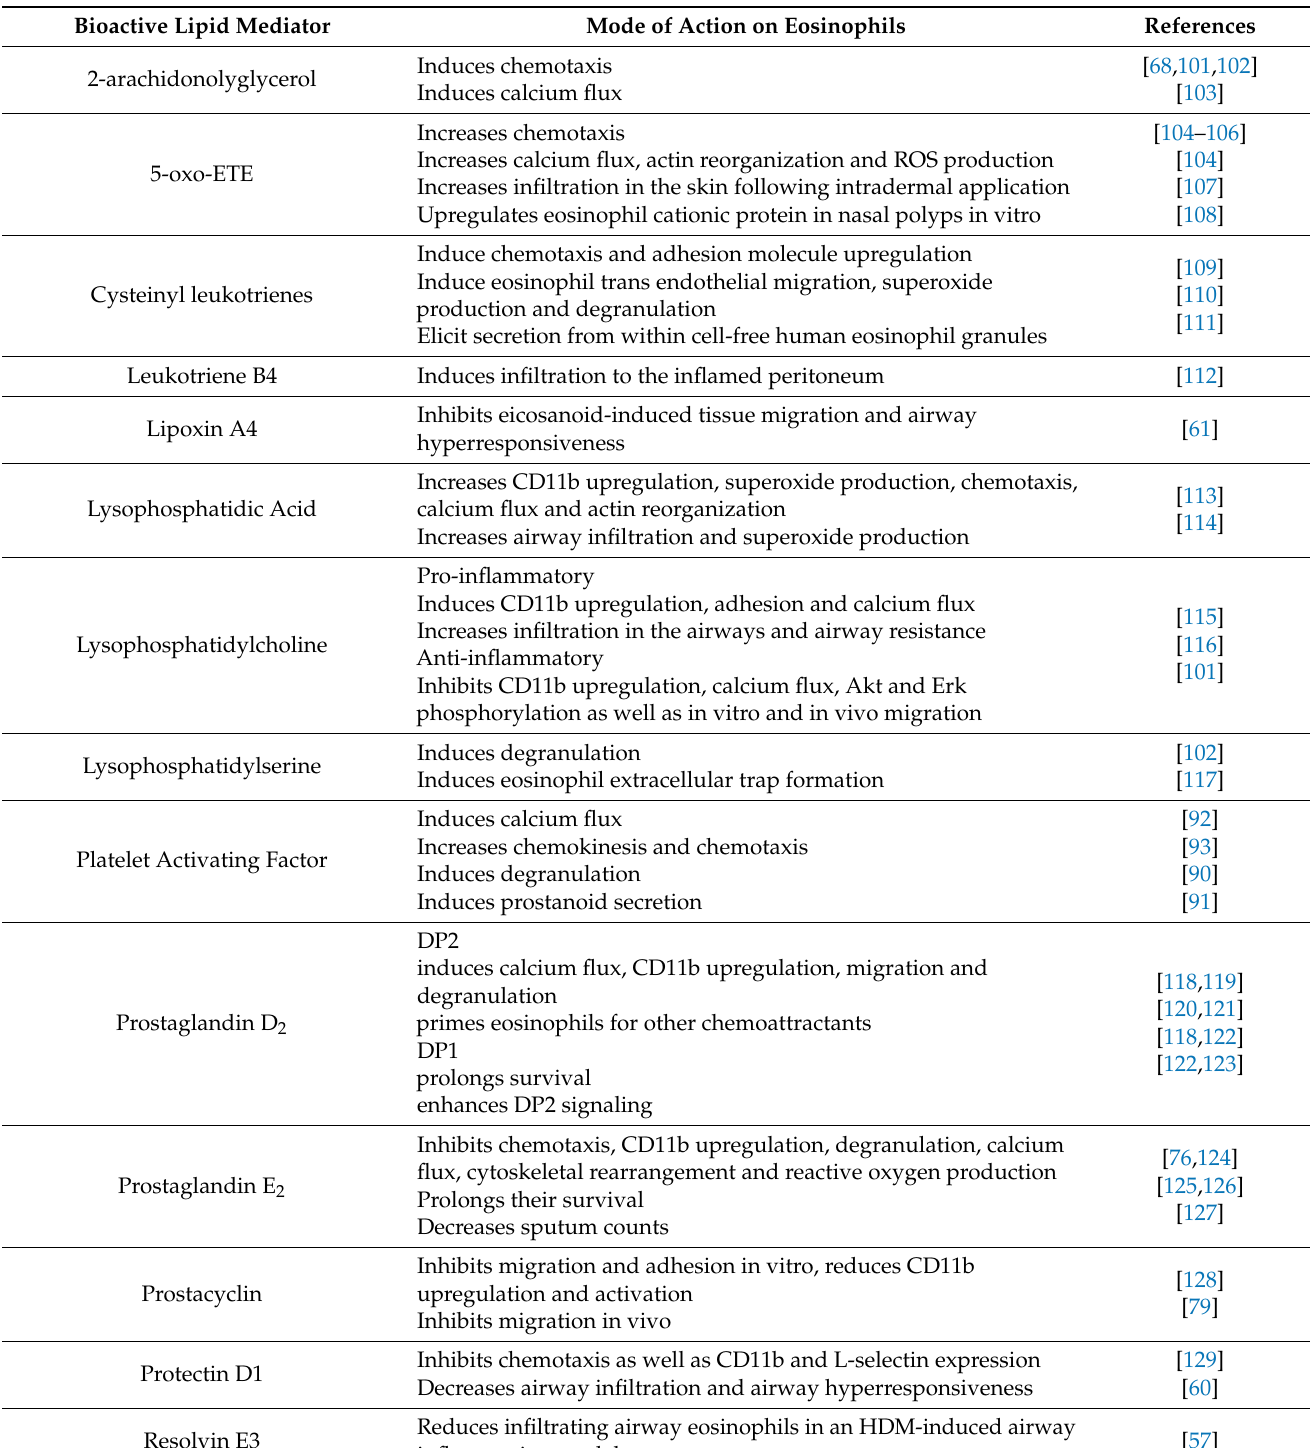
Table 2. Effects of phospholipid cleavage products on eosinophil